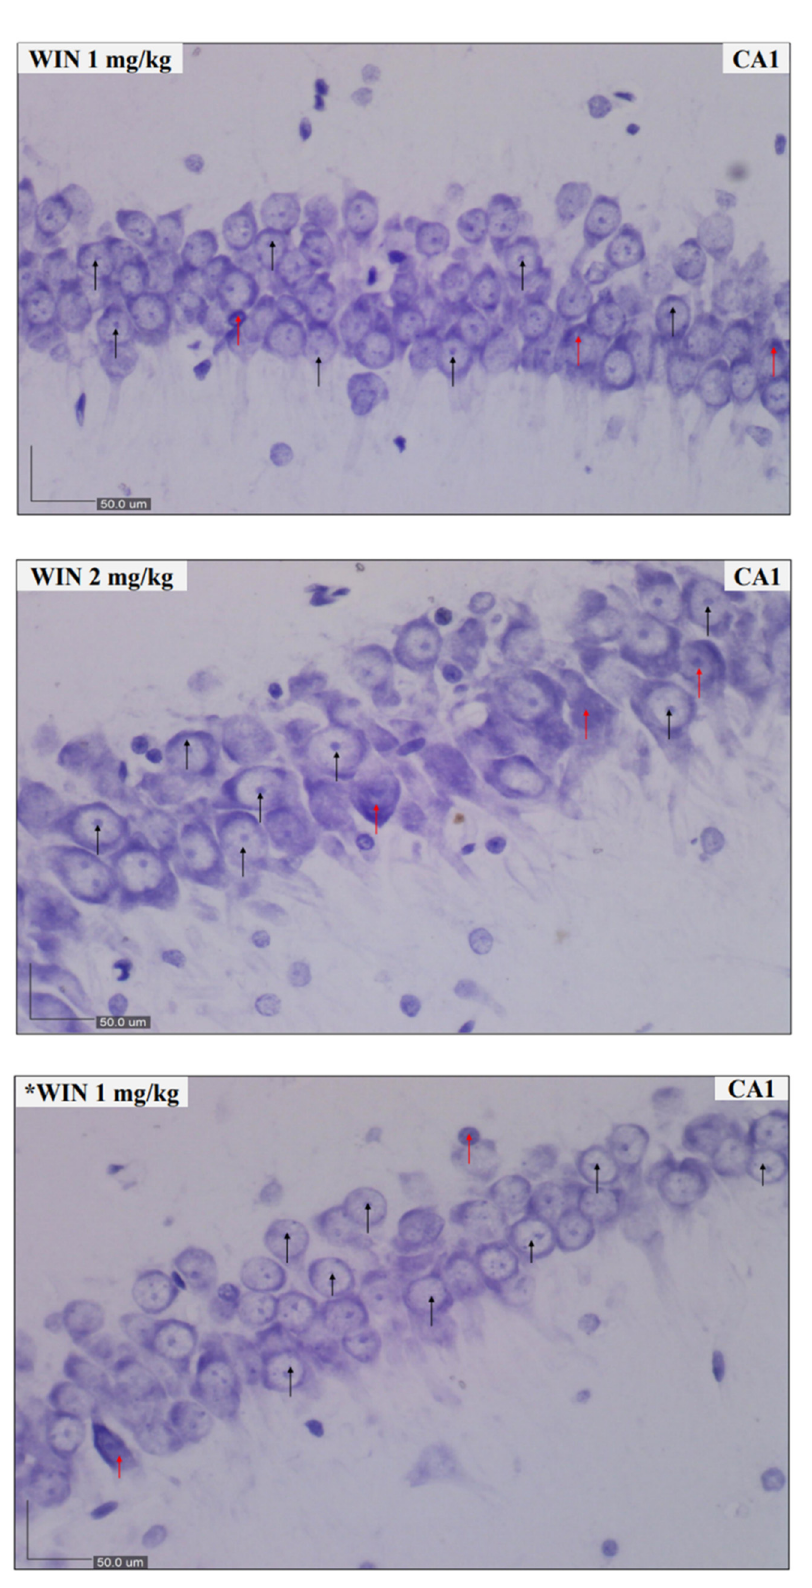
Figure 4. Representative photomicrographs of brain sections of rats (CA1 subfield of the hippocampus) stained by cresyl violet. Control, CA1–CA4—Rat hippocampus revealing all regions, (magnification ×100). Control, CA1—Control group rats showing normal histology of pyramidal cells arranged in a dense layer. Model, CA1—Model group rats indicating degenerated pyramidal cells